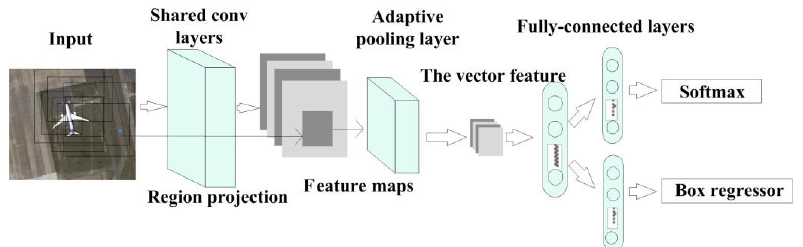
Figure 2. Diagram of the detection network.